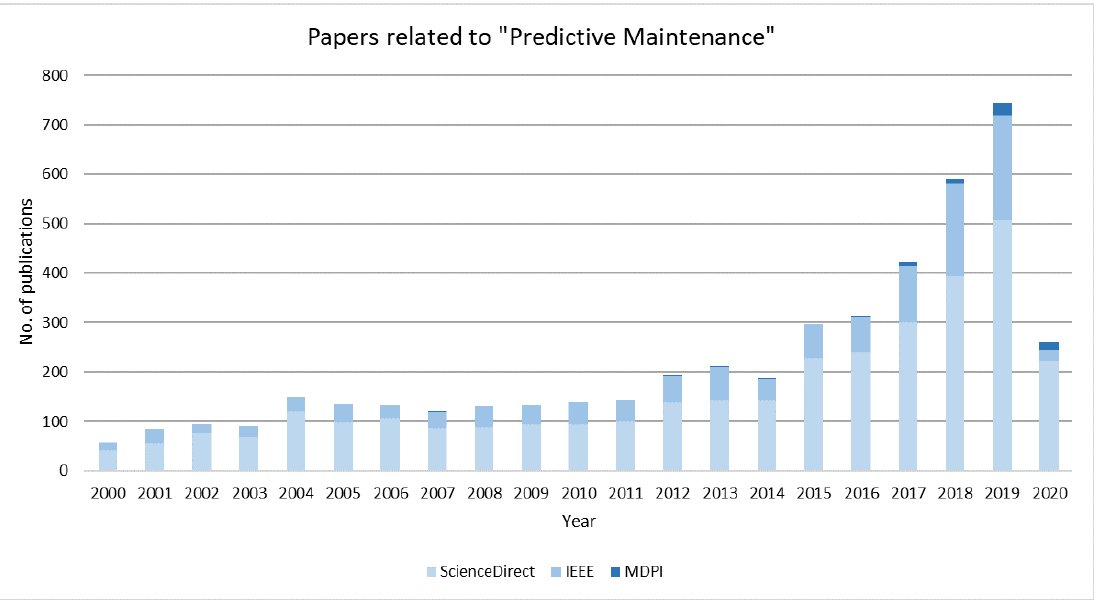
Figure 1. The published papers on predictive maintenance from 2000 to 2020 on MDPI, ScienceDirect and IEEE. Table 1. An overview of a set of review papers in relation to the field of